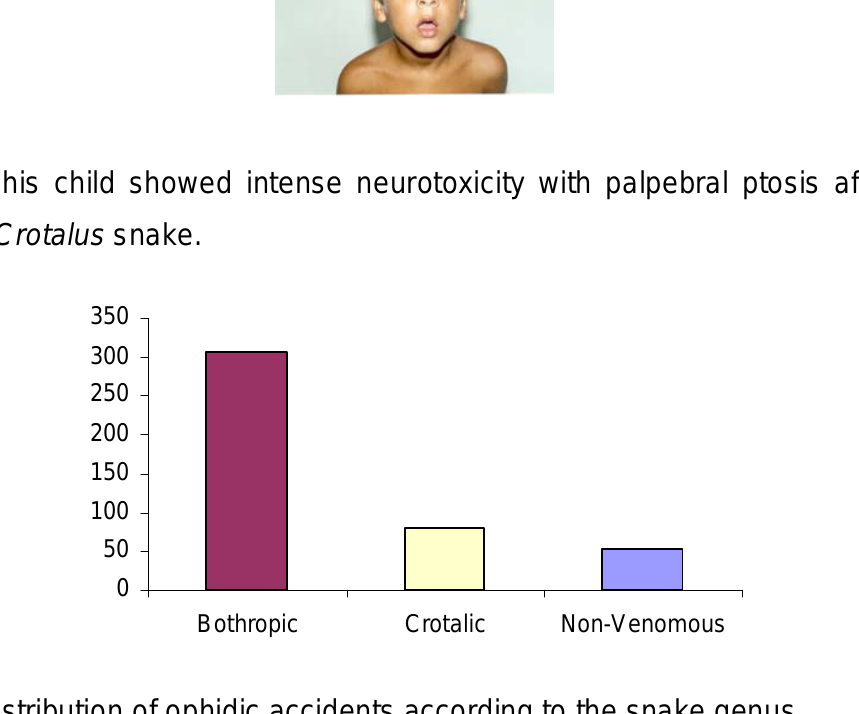
Figure 7: Distribution of ophidic accidents according to the snake